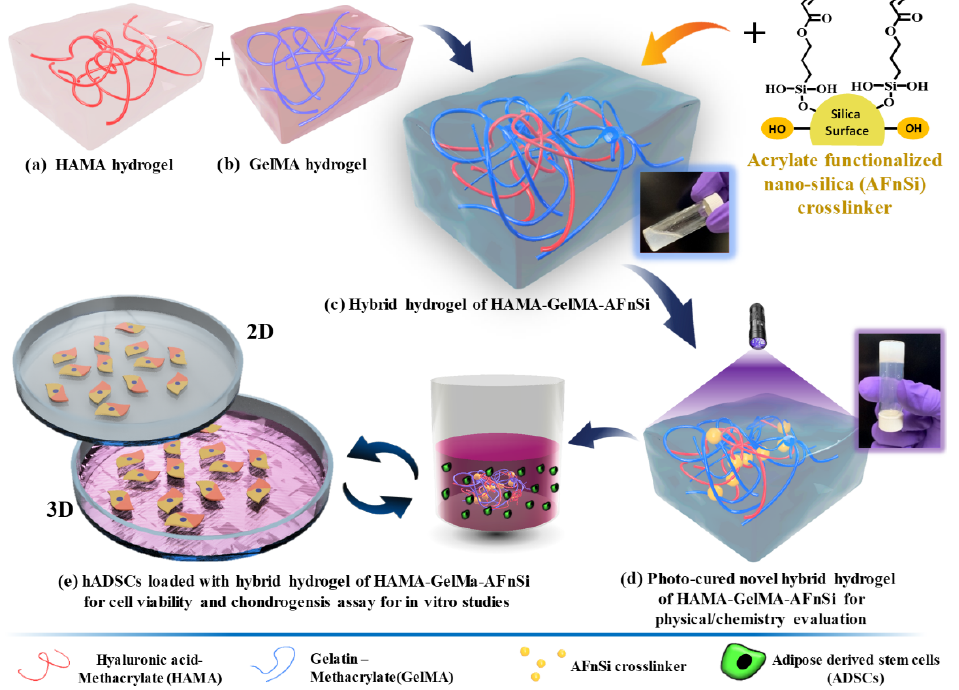
Figure 1. Schematic illustration of the experimental design and steps ( a – e ) for hADSCs loaded with optimal chondrogenic differentiation hybrid hydrogels comprised of hyaluronic acid methacryloyl (HAMA), gelatin methacryloyl (GelMA), and the acrylate-functionalized nano-silica (AFnSi) crosslinker in the in vitro studies. ( a ) 2% ( w / v ) HAMA hydrogel, ( b ) 20% ( w / v ) GelMA hydrogel, ( c ) the hybrid hydrogels of HG -AFnSi, ( d ) the hybrid hydrogels of HG -AFnSi system were photocured using LAP at 365 nm of UV light and their physicochemical characteristics were evaluated, and ( e ) the hADSCs loaded with the hybrid hydrogels of HG -AFnSi with 0–1.0 ( w / v ) AFnSi crosslinker to examine the process of cell viability and optimal chondrogenic development.